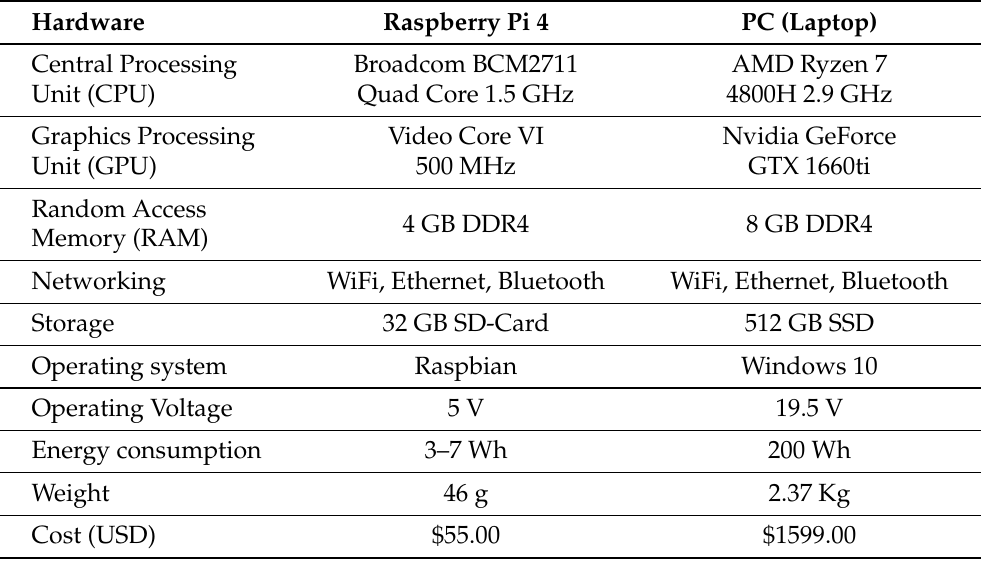
Table 1. RPi4 versus PC technical specifications